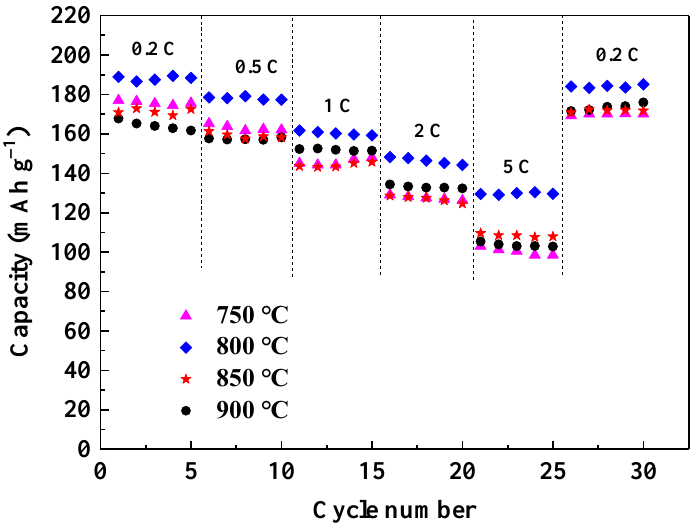
Figure 6. Rate capability of LiNi 2/3 Co 1/6 Mn 1/6 O 2 calcinated at different temperatures.